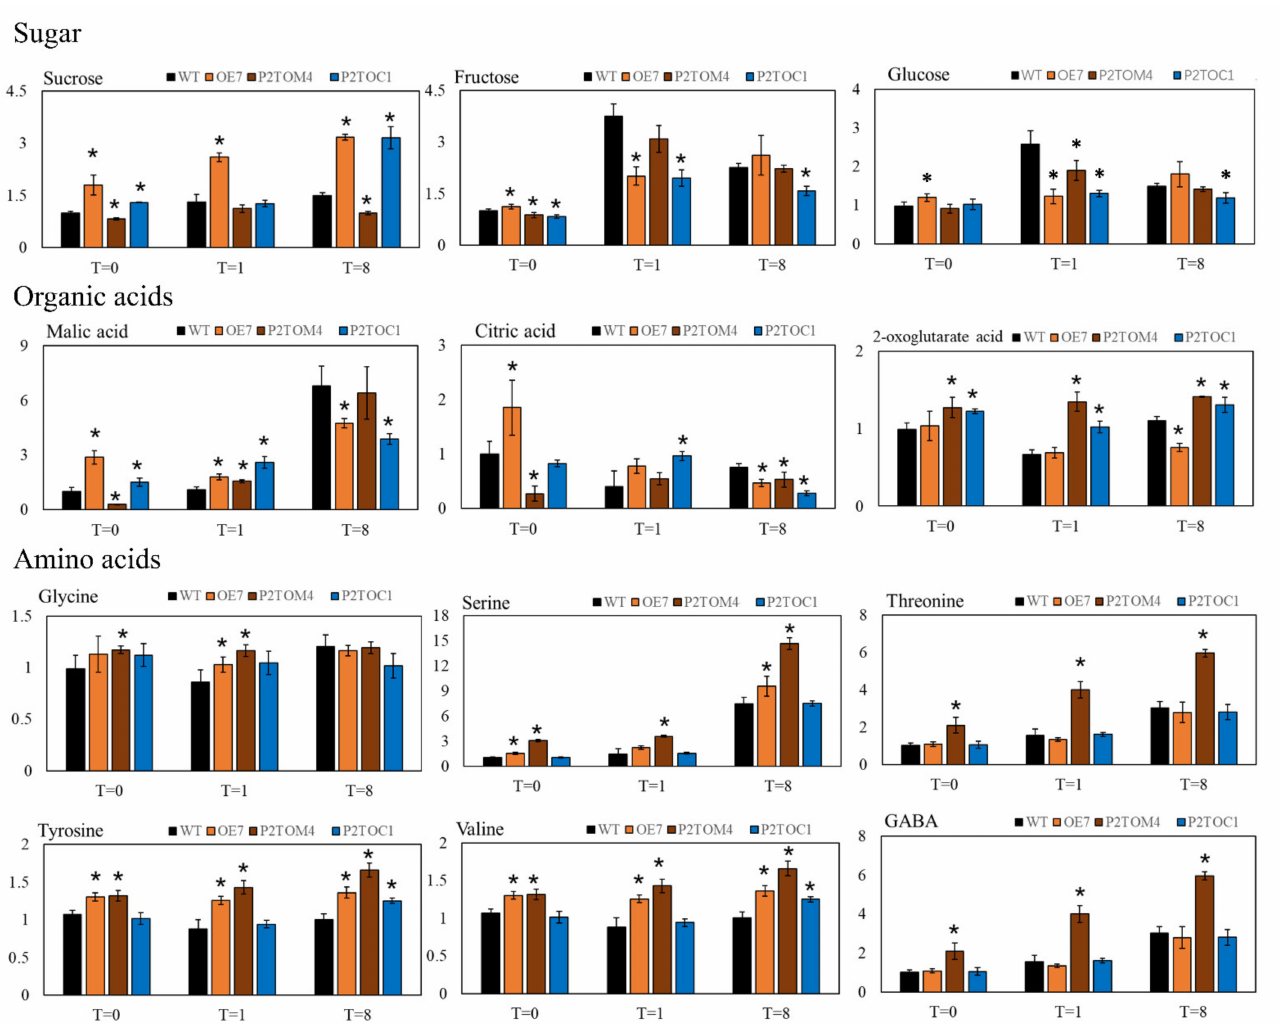
Figure 5. Metabolomic data of 20-day-old Arabidopsis leaves collected at T = 0, 1, and 8 h after illumination. Data were measured by GC-MS and normalized with data obtained from WT at T = 0. Around 150 mg FW was used in extraction and ribitol was used as internal standard. Values represented by bars are means normalized to mean data of WT at T = 0. Asterisks represent significant differences in OE7 or P2TOM or P2TOC lines compared with WT (black bar) at corresponding time points (T = 0, 1, 8), n = 4–6, * p -value < 0.05. GABA, gamma-aminobutyric